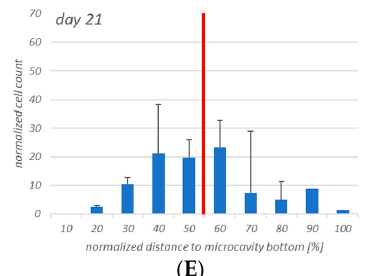
Figure 9. Four-dimensional hHSCs cell count after day 1 ( A ), day 3 ( B ), day 7 ( C ), day 14 ( D ), and day 21 ( E ). Up to day 14 it appears that two distinct populations are formed. However, at day 21 this is less pronounced. Red: Median of the distribution. n = 3, * = p < 0.05.